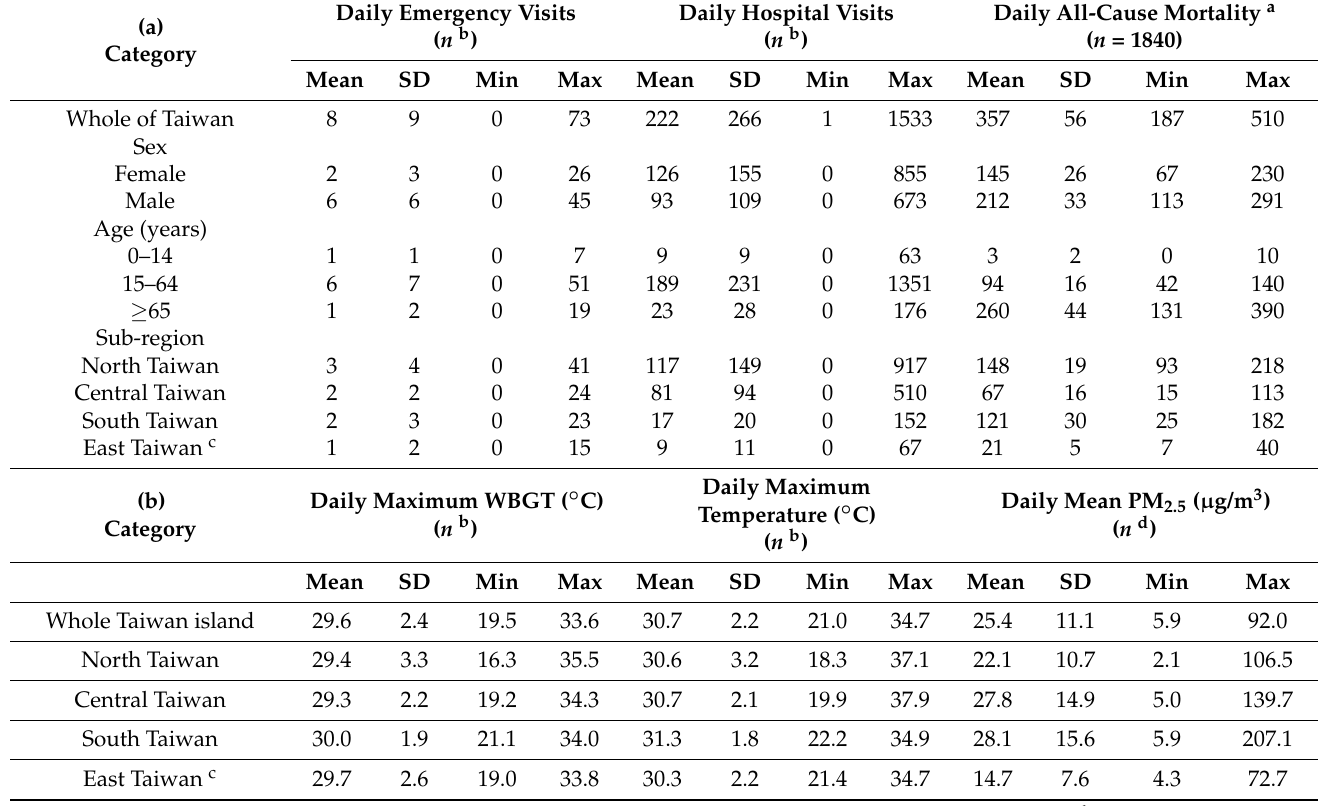
East Taiwan had the lowest counts in all three health outcomes. As for environmental data, the area-averaged daily maximum WBGT and temperature during the warm seasons of these 18 years for the whole Taiwan island were 33.6 ◦ C and 34.7 ◦ C, respectively (Table 2b). North and Central Taiwan had higher WBGT and temperature maxima than South Taiwan. This phenomenon may be counter-intuitive at first sight but was attributable to heat accumulation by the basin locations of the largest cities in North and Central Taiwan. Table 2. Summary of warm-season (a) health and (b) environmental data analyzed (May to October